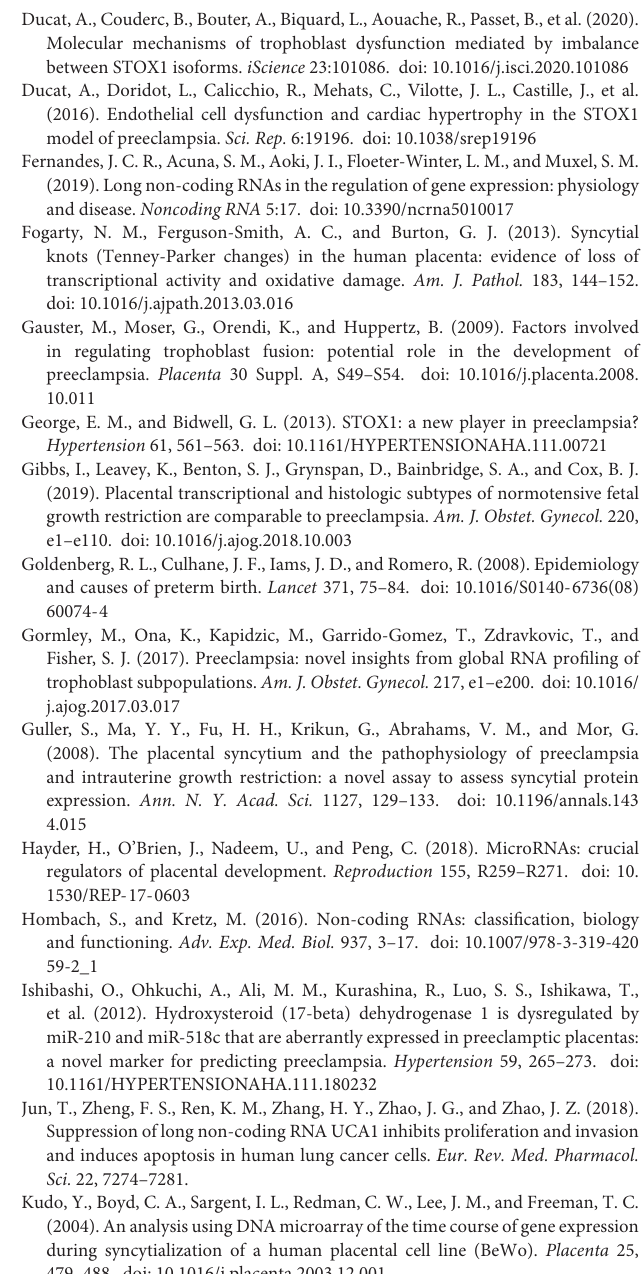
Supplementary Figure 1 | GSEA analysis of the data from the present paper in comparison with published data, demonstrating an extreme similarity of our data compared to published datasets (Shankar et al., 2015). Supplementary Figure 2 | Presentation of the network of deregulated genes in the predicted targets of miR-16, miR-455, and miR-365. Supplementary Figure 3 | STOX1 expression levels at the probe level along the gene. Junction probes analysis revealed that a large part of the 3 (cid:48) exon is less present in FSK-streated cells. This decrease in a series of probes reveal that STOX1A is twice as abundant as STOX1B when the cells are not fused, while in the context of fusion the ratio STOX1A/STOX1B drastically